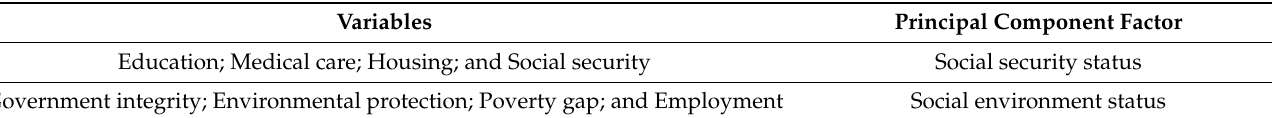
Table 5. Classification of the principal component